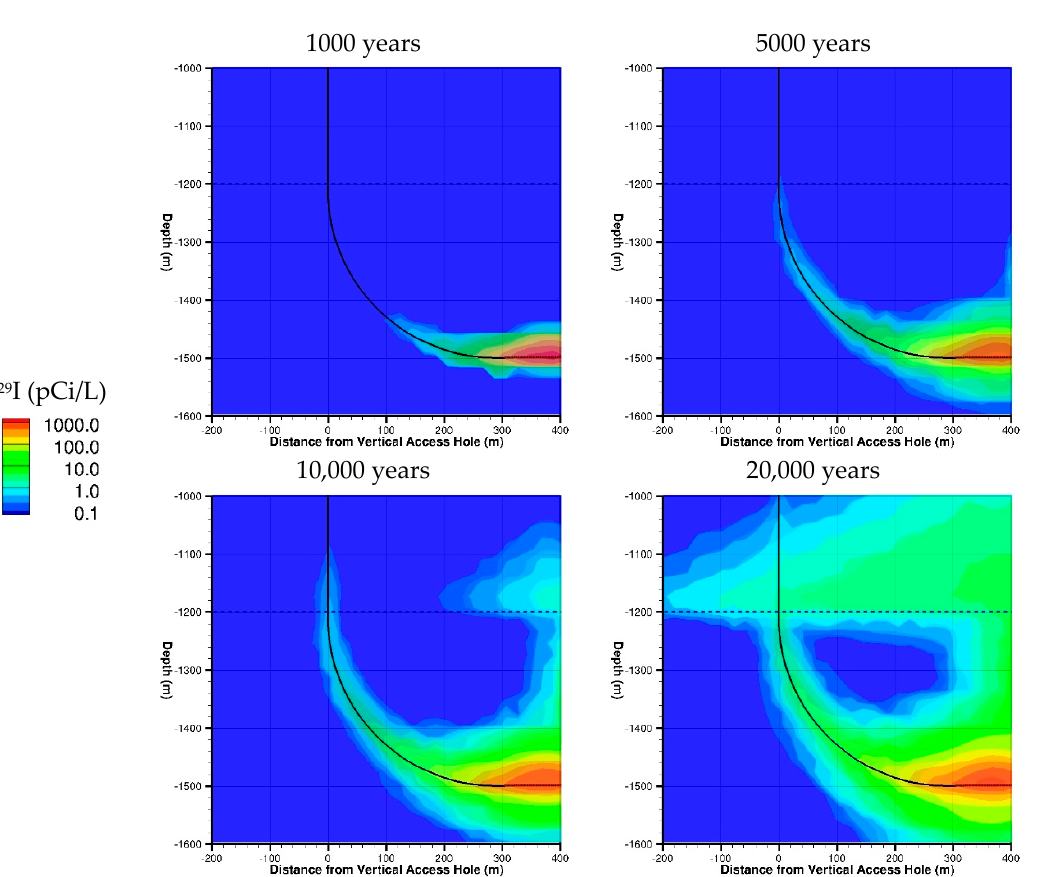
Figure 8. Distribution of 129 I activity at different times near access borehole for disruptive scenario with poorly-sealing backfill. Note that the vertical scale ends 1 km below the surface. Diffusive and advective losses from the access hole to the surrounding rock formations result in very small fluid flow and radionuclide-transport rates in the upper reaches of the access hole.